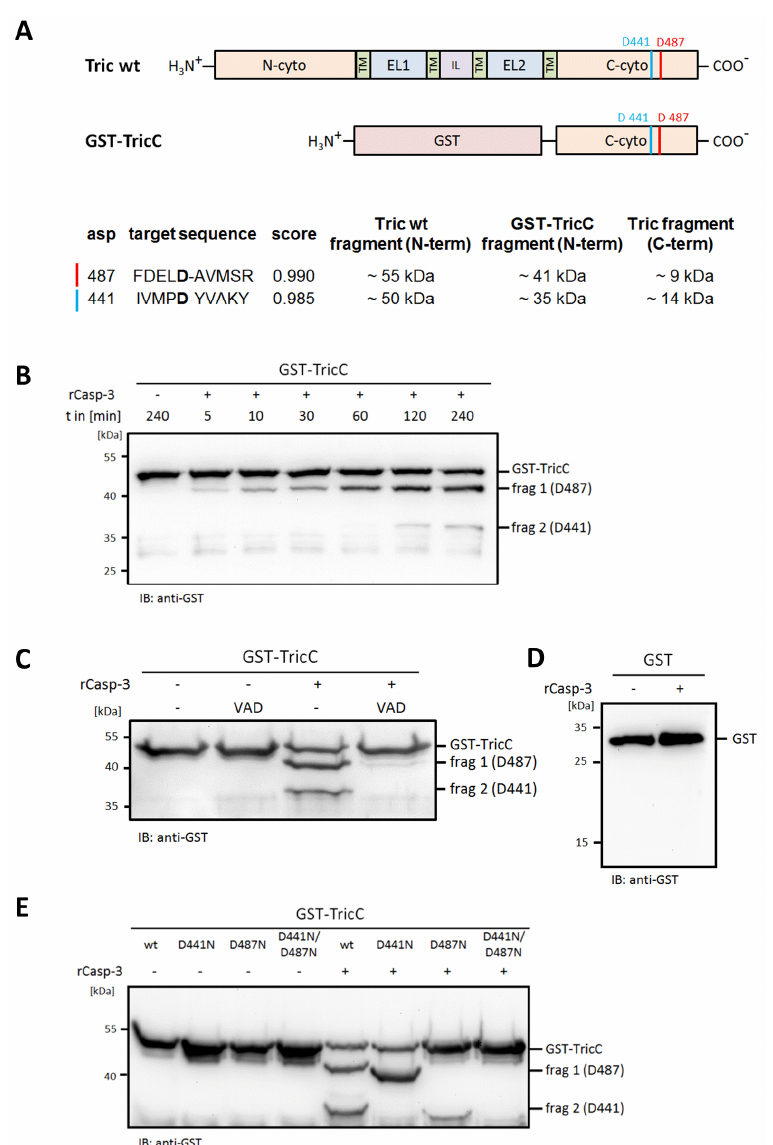
Figure 2. Identification of D487 and D441 as potential caspase-3 cleavage-sites in human tricellulin. ( A ) Schematic overview of the full-length tricellulin structure including the four transmembrane domains (TM), extracellular loops 1 and 2 (EL1, EL2), the intracellular loop (IL) and the potential caspase cleavage-sites D487 and D441. The table summarizes the molecular masses of the corresponding caspase cleavage-products expected for an in vitro caspase assay using recombinant GST-TricC fusion protein as substrate. ( B ) Time-dependent generation of the GST-TricC cleavage-products frag 1 and frag 2 after addition of recombinant caspase-3. The image is a representative of n = 2. ( C ) In the presence of pan-caspase inhibitor Z-VAD-FMK, fragmentation of GST-TricC is inhibited. ( D ) GST was used as a control and was not fragmented by caspase-3. ( E ) Mutation of potential caspase-3 cleavage-sites disable cleavage of GST-TricC partly (GST-TricC-D441N, GST-TricC-D487N) or completely (GST-TricC-D441N /